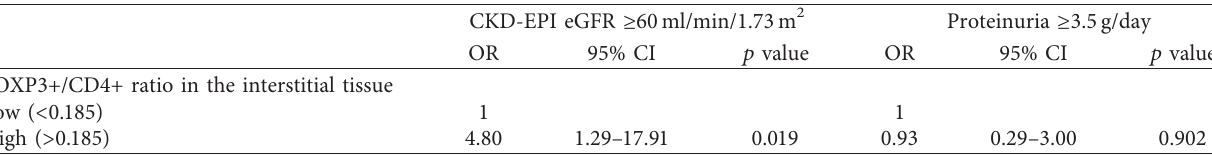
Table 5: Association between high FOXP3+/CD4+ ratio in the interstitial tissue (above average value: 0.185) with renal function level and proteinuria at biopsy using multivariable logistic